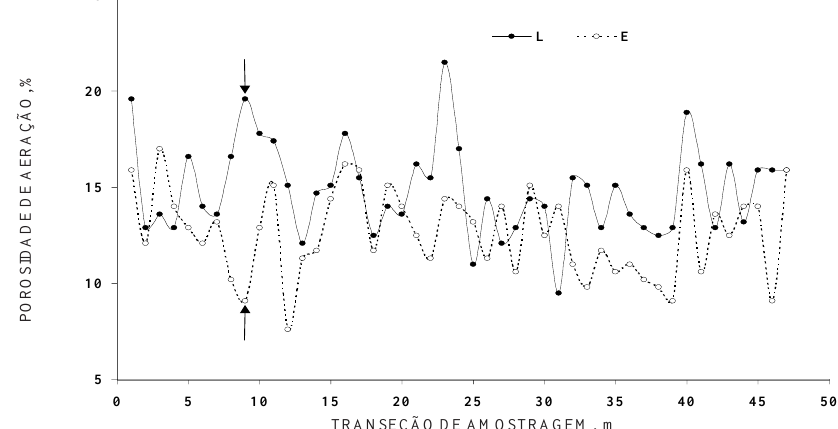
Figura 4. Porosidade de aeração na linha (L) e entrelinha (E) no sistema de semeadura direta ao longo de uma transeção perpendicular às linhas de cultivo em um Latossolo Roxo cultivado com milho, para umidade do solo equivalente à tensão de 0,033